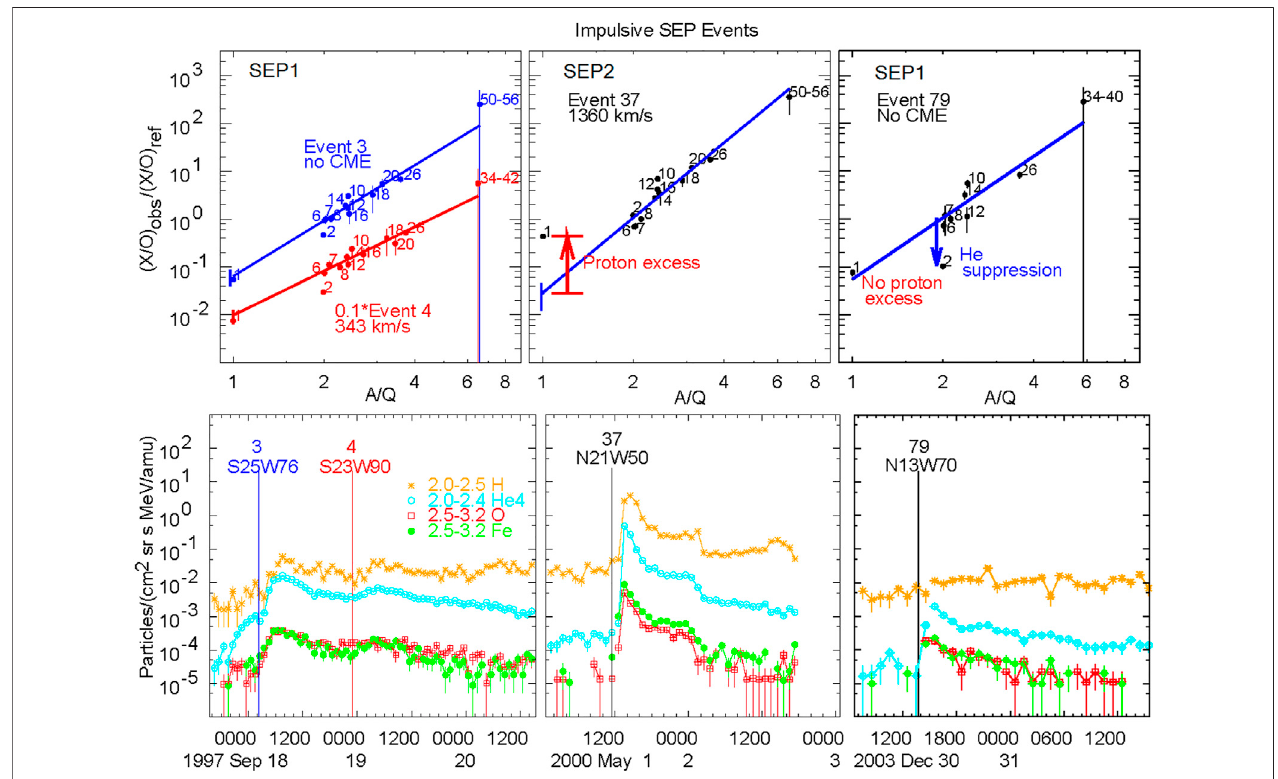
FIGURE 2 | Lower panels show time histories of H, 4 He, O and Fe, at the indicated MeV amu − 1 , for four impulsive SEP events, two small SEP1 events on the left and alarger SEP2 event in the center , and a 4 He-poor SEP1 event on the right . Event numbers shown above source coordinates refer tothe eventlist ofReames et al. (2014a). Power-law fi ts to the abundance enhancements, noted by Z , in each event, are shown in the upper panels and CME speeds are listed when CMEs are seen. The center Event37isanSEP2classeventbecauseofitslargeprotonexcessnoted.FortheSEP1eventsonthe left and right ,theprotonsabundanceslieonthe extrapolated power-law fi ts (Reames, 2019b,